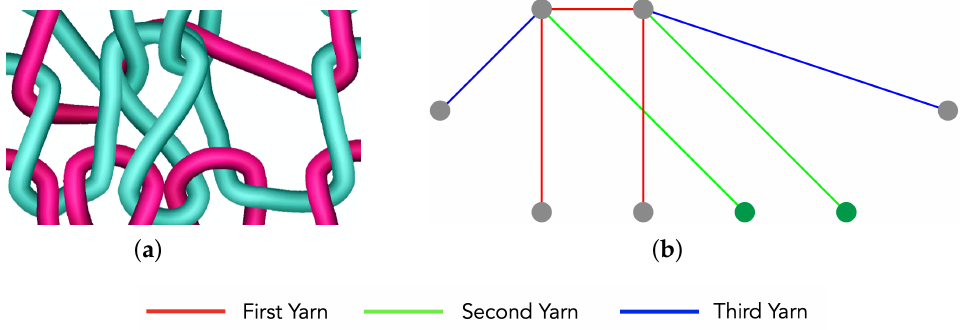
Figure 19. Yarn order zoom-in at location (4, 5) in the yarn topology graph of Figure 13: ( a ) Simulated knitted pattern. ( b ) Corresponding zoom-in topology